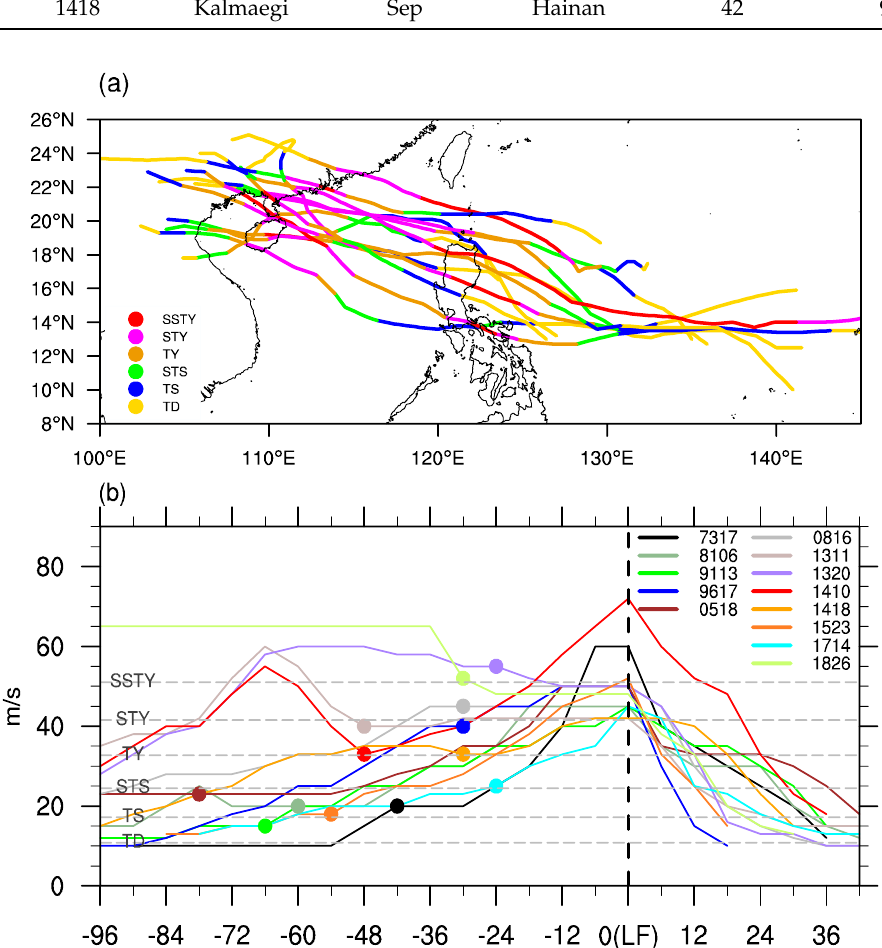
Figure 1. Tracks ( a ) and temporal variations in the intensity ( b , units: m s − 1 ) of the 13 LSTYs in SC with 6 h intervals from 96 h before landfall (LF) to 42 h after LF. The vertical dash line and solid circles in ( b ) indicate the landfall time and the time of the LSTYs move into the SCS (west of 120° E), respectively.